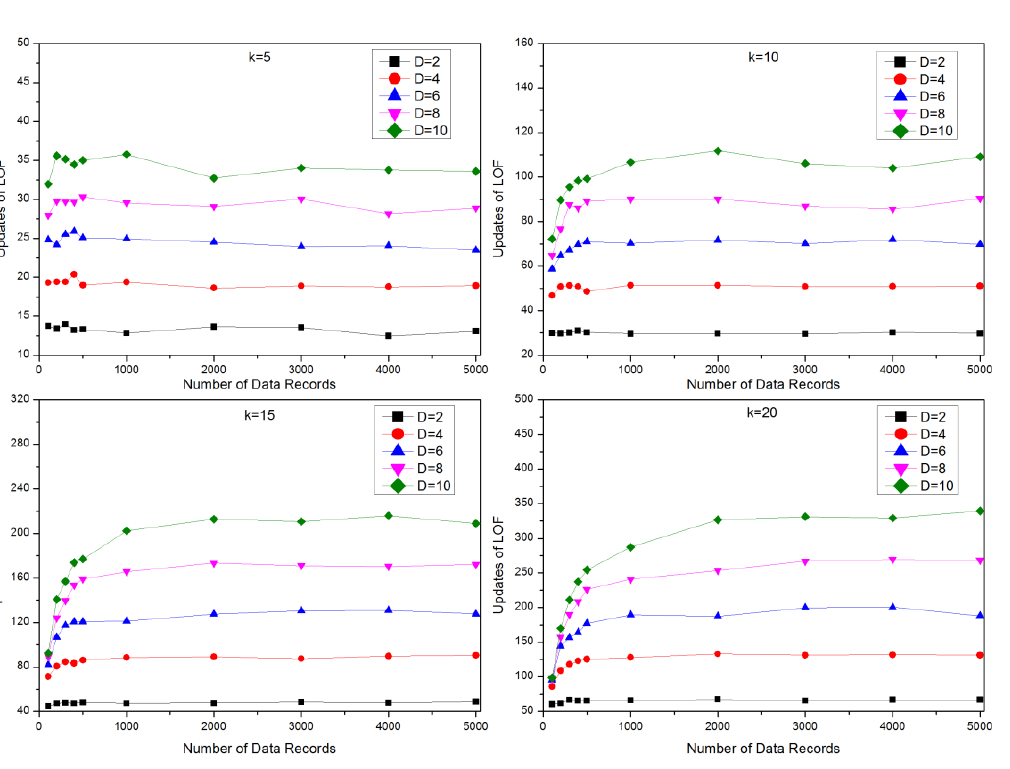
Figure 3. The dependence of the number of CLOF updates on the total number of data records N , data dimension D , and parameter k in standard Gaussian distribution.